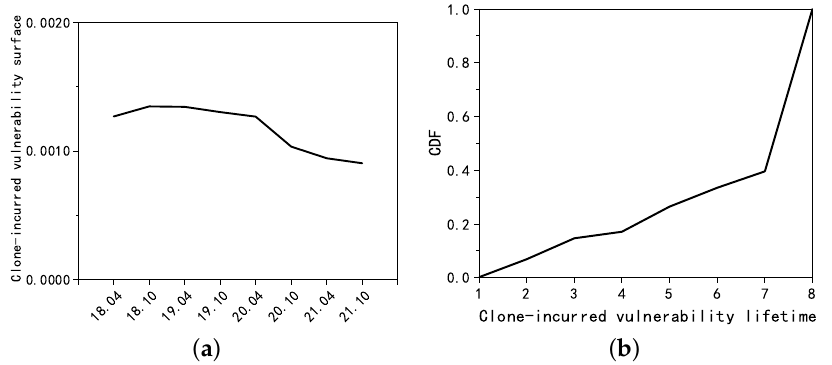
Figure 6. The clone-incurred vulnerability surface and clone-incurred vulnerability lifetime in Linux. ( a ) The clone-incurred vulnerability surface for Linux. ( b ) The CDF for the clone-incurred vulnerability lifetime in